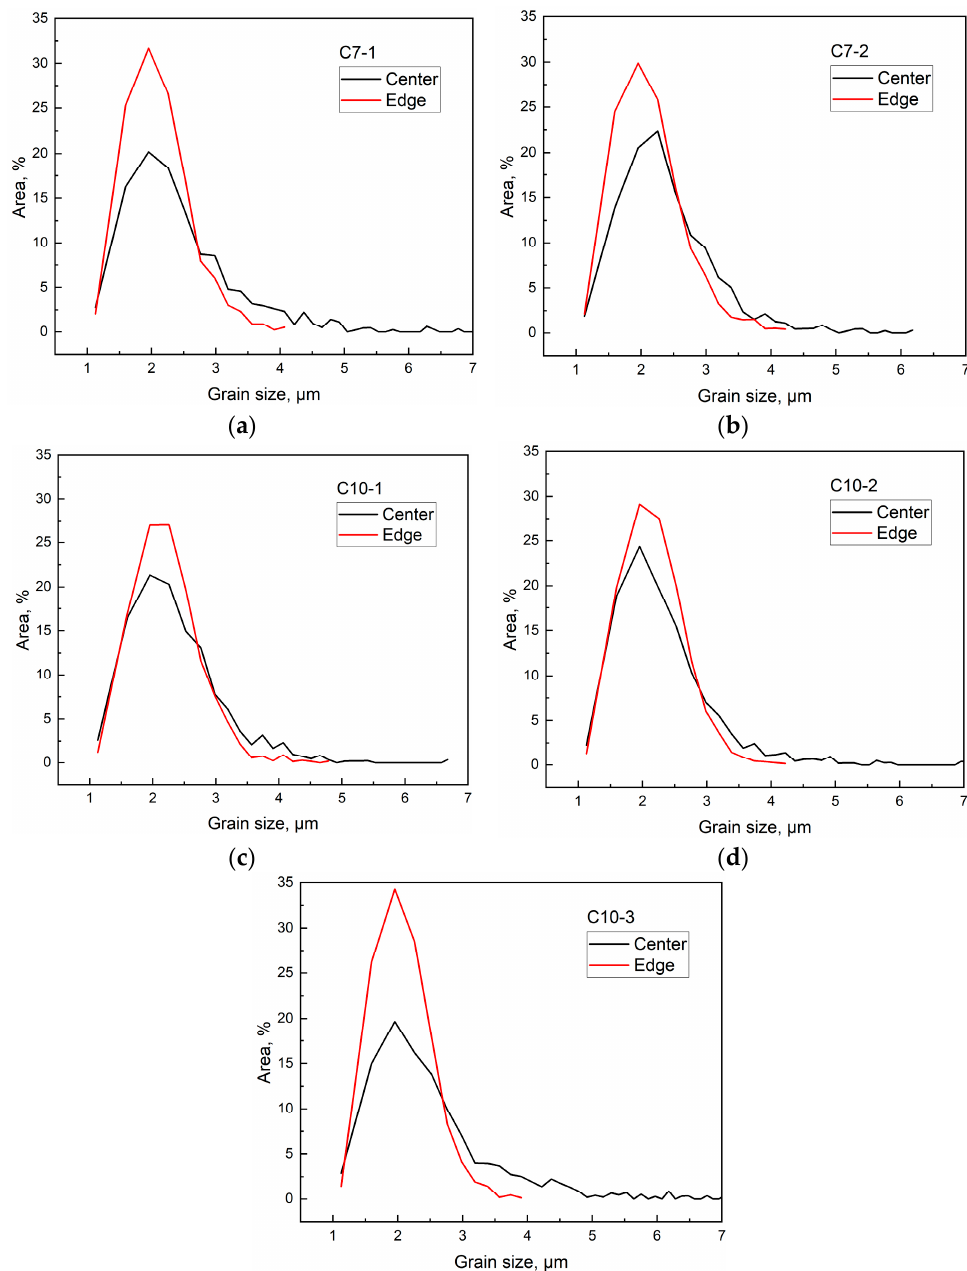
Figure 9. Dependences of the relative area occupied by grains on their size in the central and edge regions of samples ( a ) C7-1 (near the region of destruction of the wire C7), ( b ) C7-2 (far from the region of destruction), ( c ) C10-1 (from the area of the C10 wire near the 1st clamp), ( d ) C10-2 (from the center of the C10 wire), and ( e ) C10-3 (from the area of the C10 wire near the 2nd clamp).